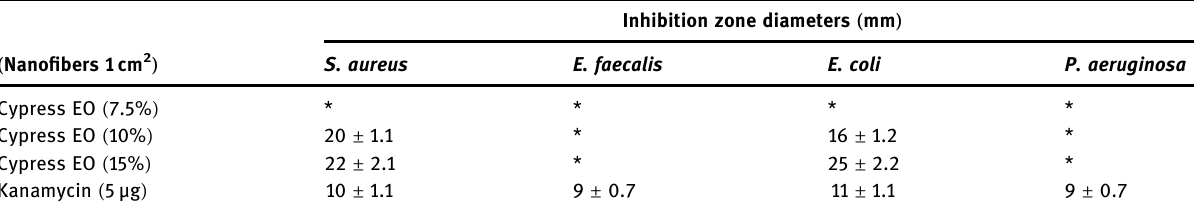
Inhibition zone diameters ( mm )